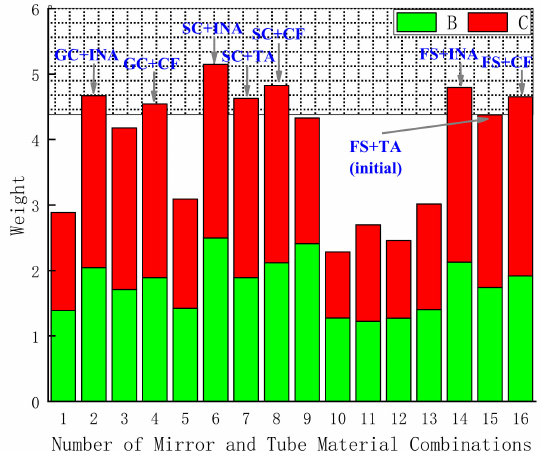
Figure 11. Weight map for different material